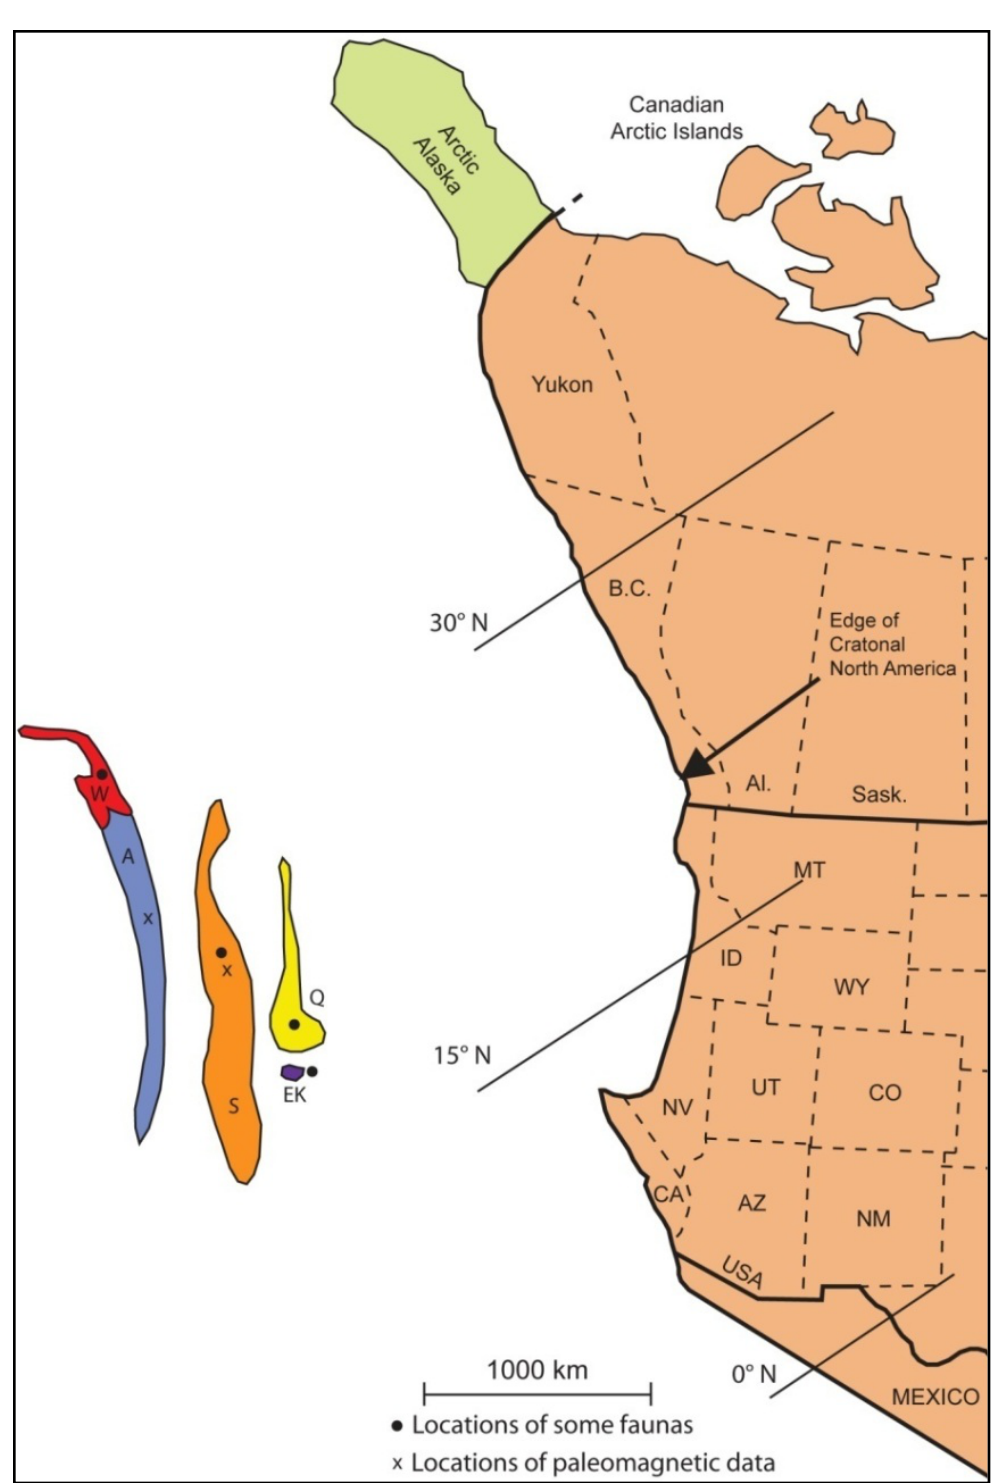
Figure 4. Interpreted Early Permian position of allochthonous terranes. For abbreviations see caption for Figure 3. Paleolatitudes for cratonal North America are from Scotese and McKerrow